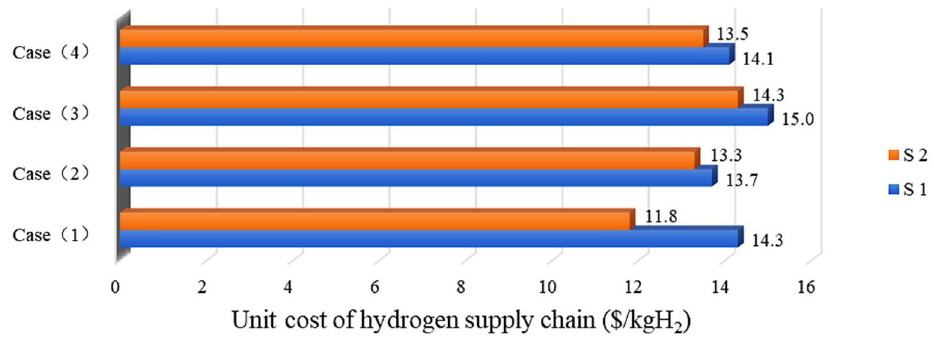
Figure 12. Unit cost of hydrogen supply chain about different cases for two scenarios (USD/kgH 2 ).